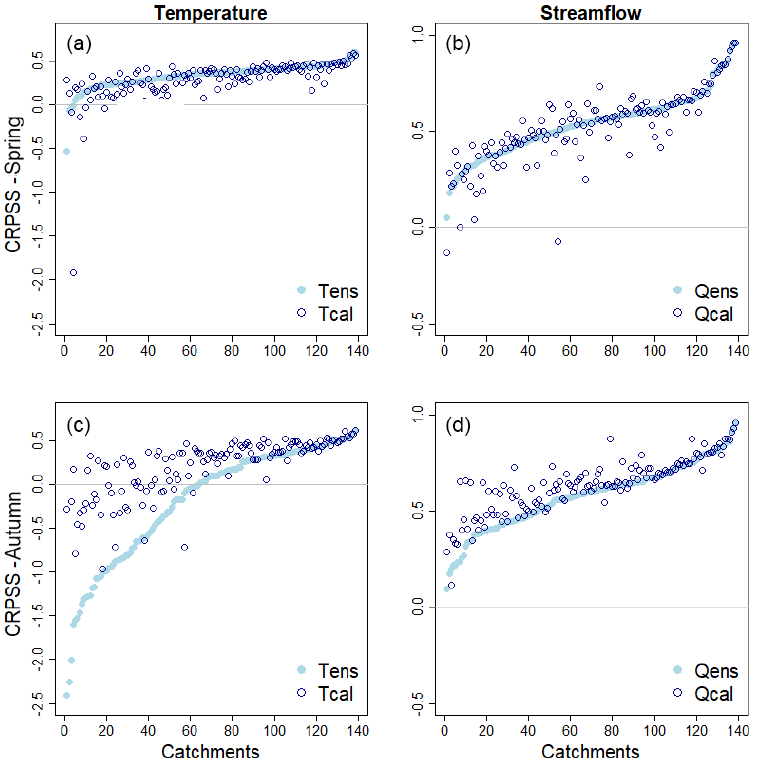
Figure 6. Temperature ( T ens and T cal , a, c ) and streamflow ( Q ens and Q cal , b, d ) CRPSS for SPRING (a, b) and AUTUMN (c, d) . The catchments are ordered by increasing CRPSS for T ens and Q ens (light blue dots); the catchment calibrated values ( T cal and Q cal ) are plotted as blue circles. All results are presented for a lead time of 5 days.